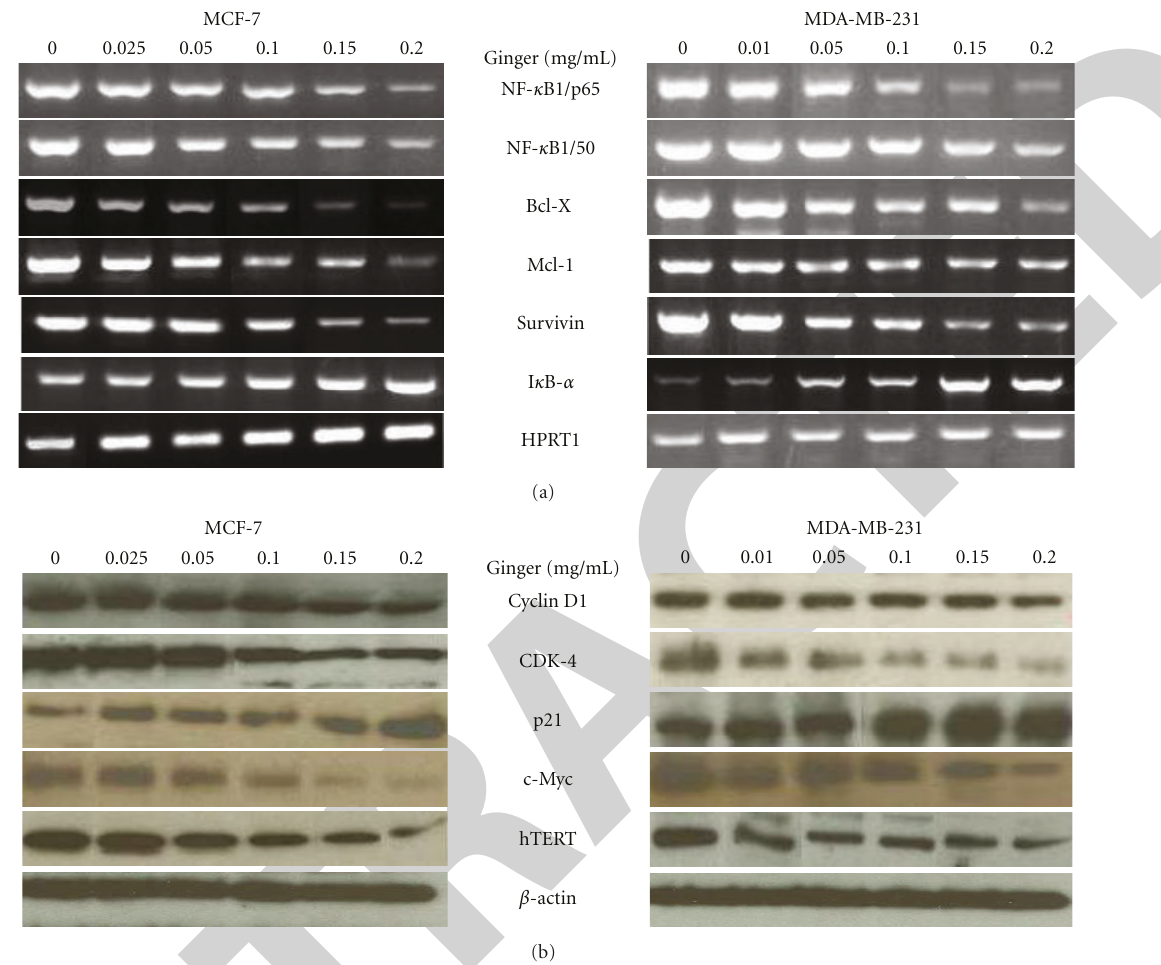
Figure 5: Ginger extract modulates expression levels of the cell survival and cell-cycle regulators. The MCF-7 and MDA-MB-231 cells were incubated with the indicated concentrations of the ethanol extract of ginger for 24 h, then cells were harvested and assayed. (a) The total RNAs were isolated, reverse transcribed, and subjected to PCR with the gene-specific primers. The PCR products of the depicted genes were then subjected to electrophoresis in 1% agarose gel and visualized by EtBr staining. HPRT1 was used as the internal control. A typical result from three independent experiments is shown. (b) Cell lysates were examined for the displayed proteins by western blot as described in the Materials and methods. β -actin was used as the internal control. Representative blots from three independent experiments are